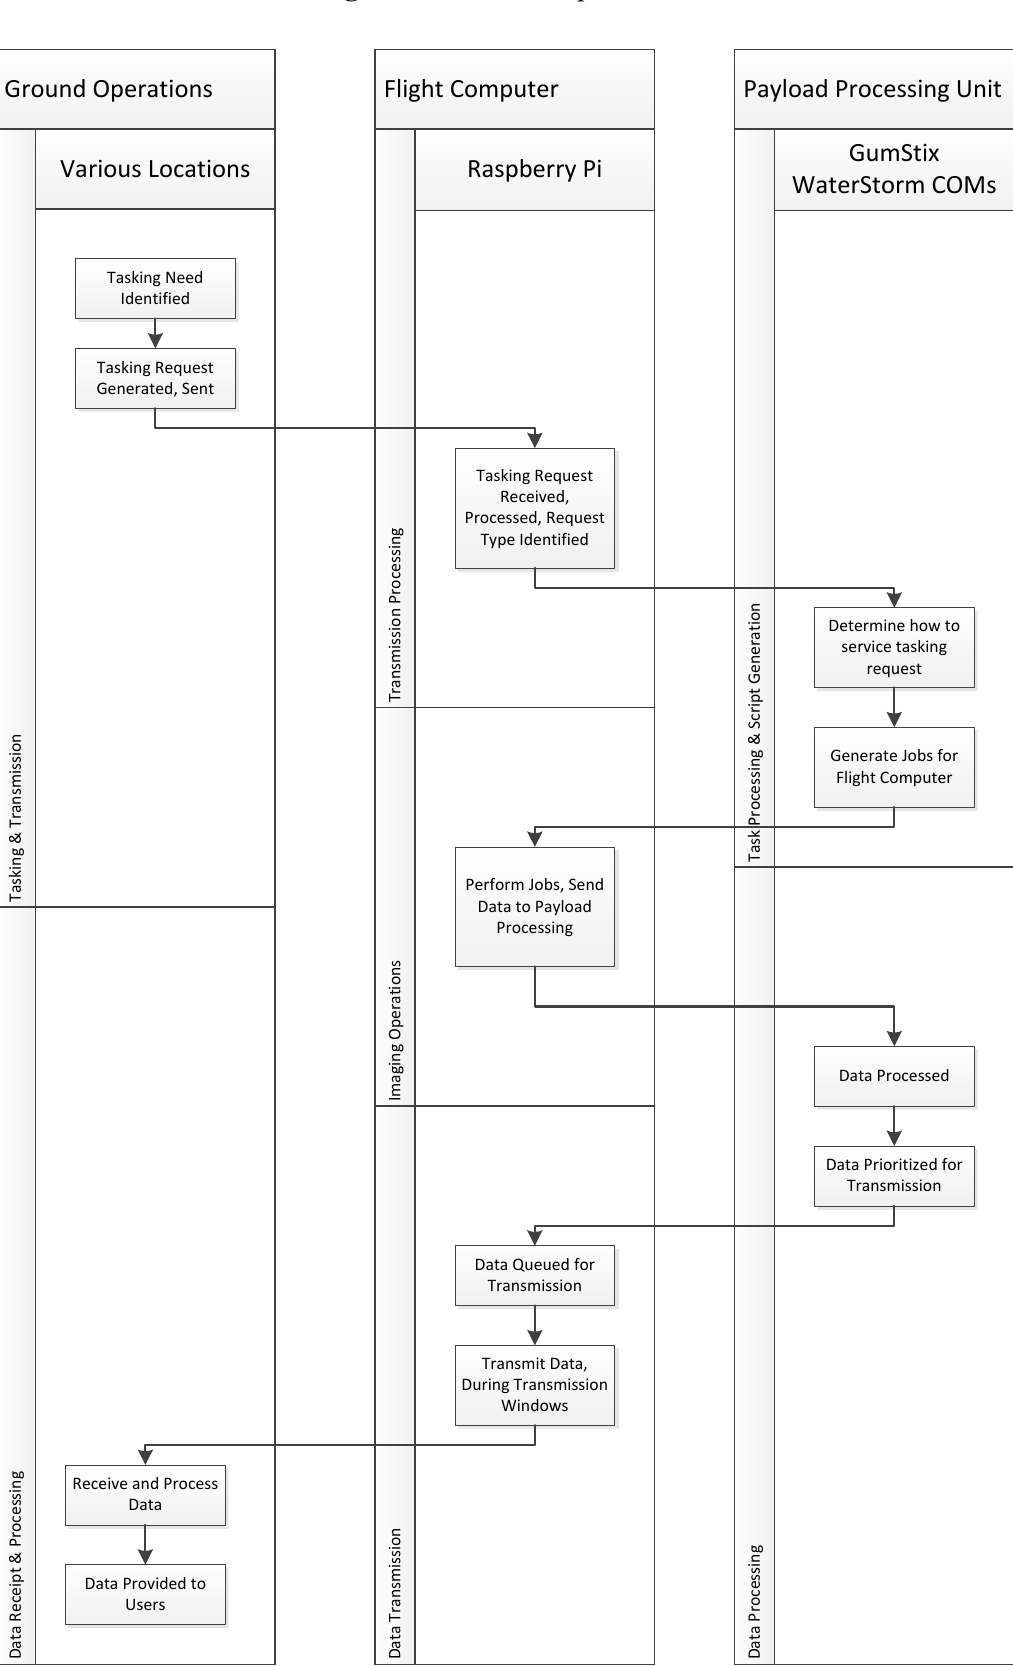
Figure 4. Software